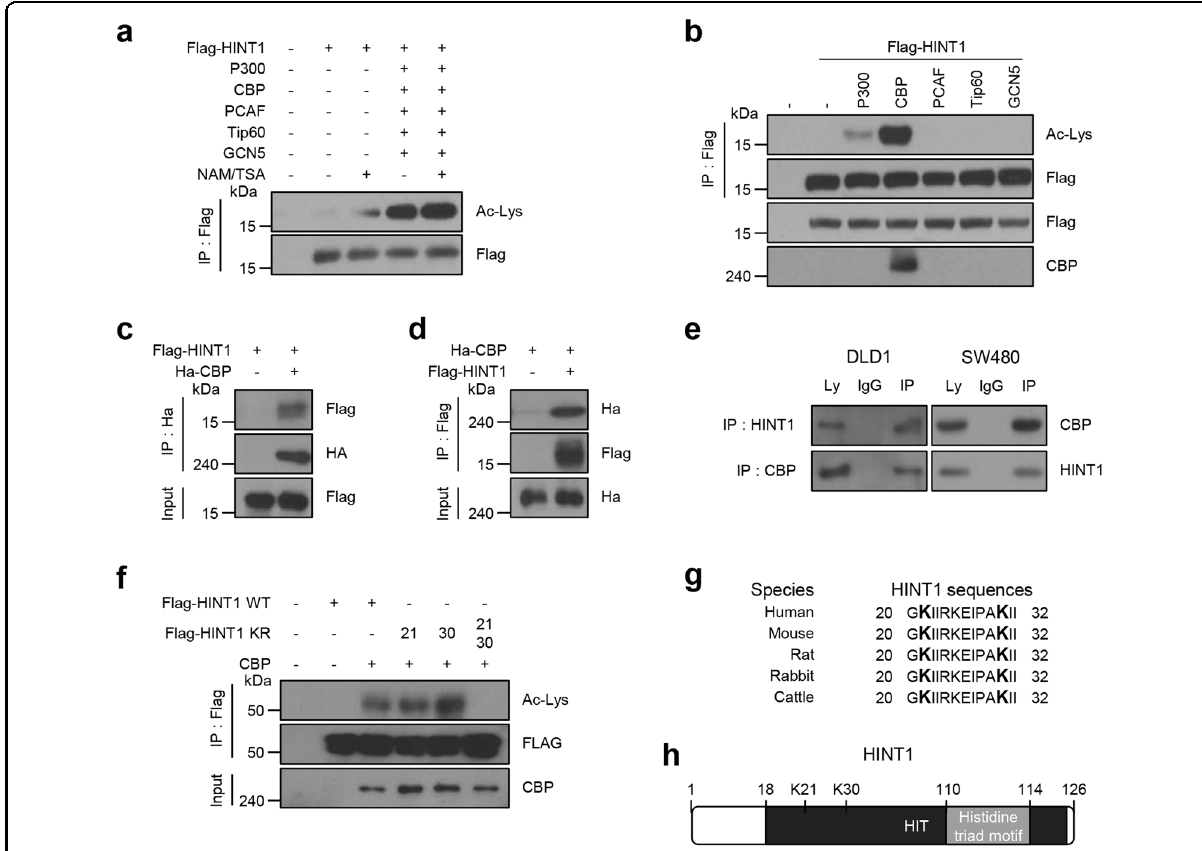
Fig. 1 HINT1 binds to and is acetylated by CBP. Flag-HINT1 was coexpressed with all a or each b of the indicated HATs, p300, CBP, Tip60, pCAF, and Gcn5, in HEK293T cells, and then cells were treated with nicotinamide (NAM, 10 mM for 12 h) and trichostatin A (TSA, 1 µM for 12 h). Acetylation levels of Flag-bead-immunoprecipitated (IPed) HINT1 were determined by immunoblot analysis using pan-acetyl lysine (Ack) antibody. For the reciprocal interaction between HINT1 and CBP, Flag-HINT1 was coexpressed with HA-CBP in HEK293T cells. HINT1 or CBP was immunoprecipitated with HA c or Flag d antibody, respectively, following western blot analysis using antibodies as indicated. e Endogenous HINT1 or CBP proteins in DLD1 or SW480 cells were immunoprecipitated and immunoblotted with antibodies as indicated. f CBP was coexpressed with each of the Flag- HINT1 wild-type versions or mutants (K21R, K30R, K21/30R; lysine to arginine) in HEK293T cells. Acetylation levels of Flag-bead-IPed HINT1 were examined by immunoblot analysis. g Sequence alignment of the putative acetylation sites K21 and K30 in HINT1 from different species. h Schematic representation of the positions of putative acetylation sites K21 and K30 within